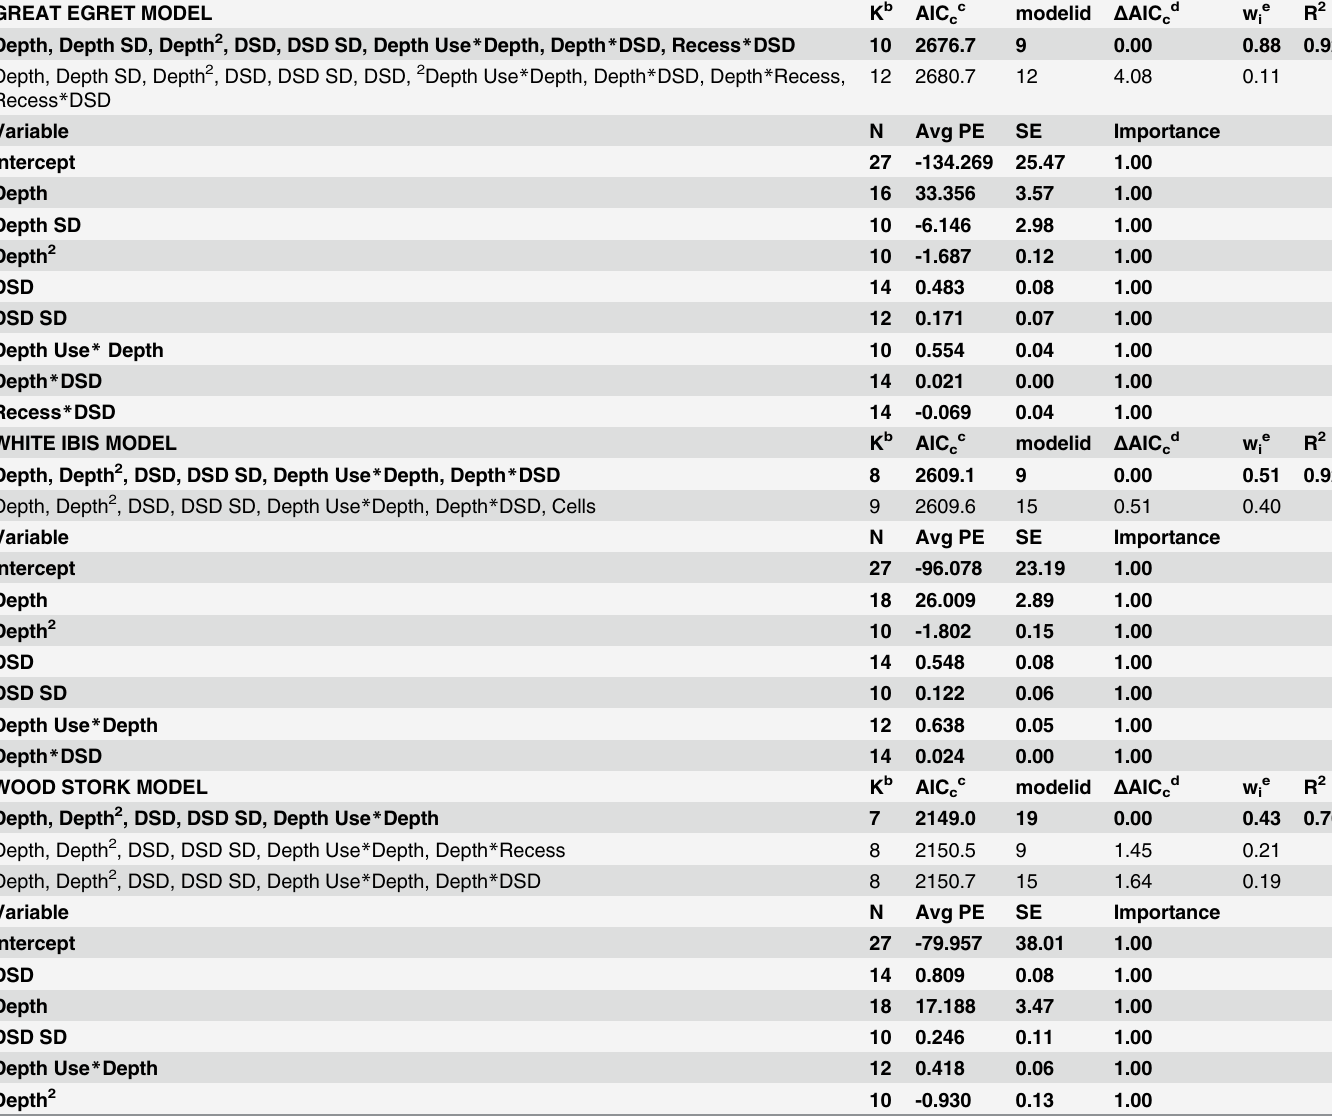
Models are ranked by differences in Akaike ’ s information criterion and only candidate models within Δ AIC cd (cid:3) 4.0 are presented. Model selection results are followed by model averaging results for each species. The R 2 represents the model fi t for the estimated mean daily DSD use vs. model averaged predicted